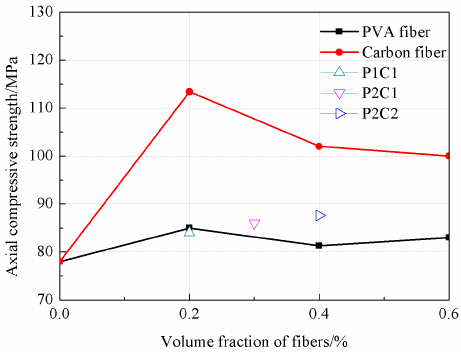
Figure 5. The tendency of the axial compressive strength.